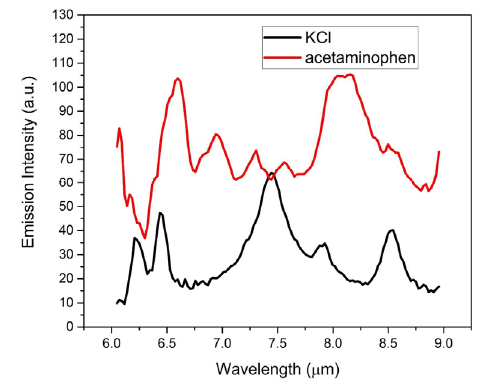
Figure 16. Single-shot LWIR LIBS spectra of acetaminophen (red) and KCl (black) after integrating all 26 individual spectra from row Y45 to row Y70.